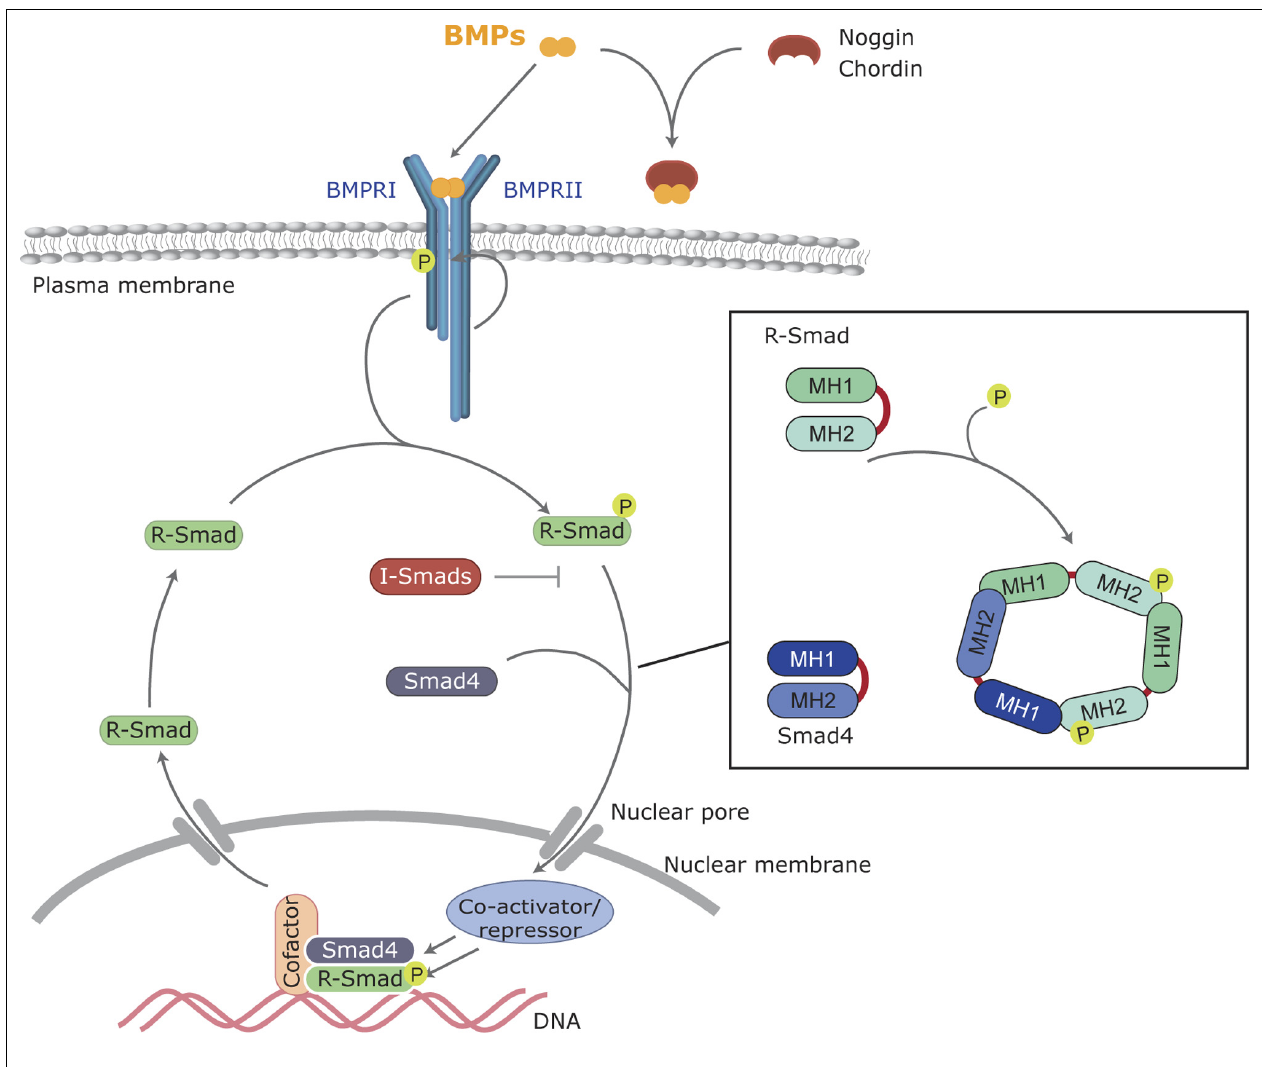
with the common Smad (Smad4) and enter the nucleus, where they regulate transcriptional processes. BMP signaling can be inhibited by extracellular antagonists, such as Noggin and Chordin, or intracellularly by